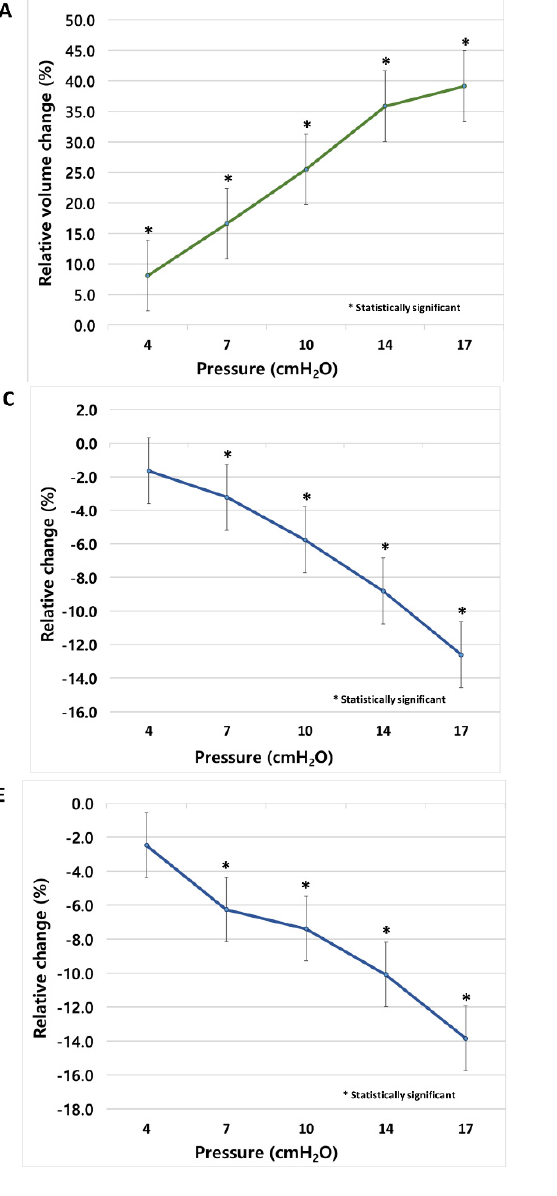
Figure 3. Lung volume and dose parameter change comparison with baseline; ( A ) volume, ( B ) D mean , ( C ) V5, ( D ) V10, ( E ) V15, and ( F ) V20. Statistically significant, *. The D mean for the lung were 1573.5 ± 314.0 cGy, 1545.9 ± 327.7 cGy, 1495.3 ± 330.8 cGy,